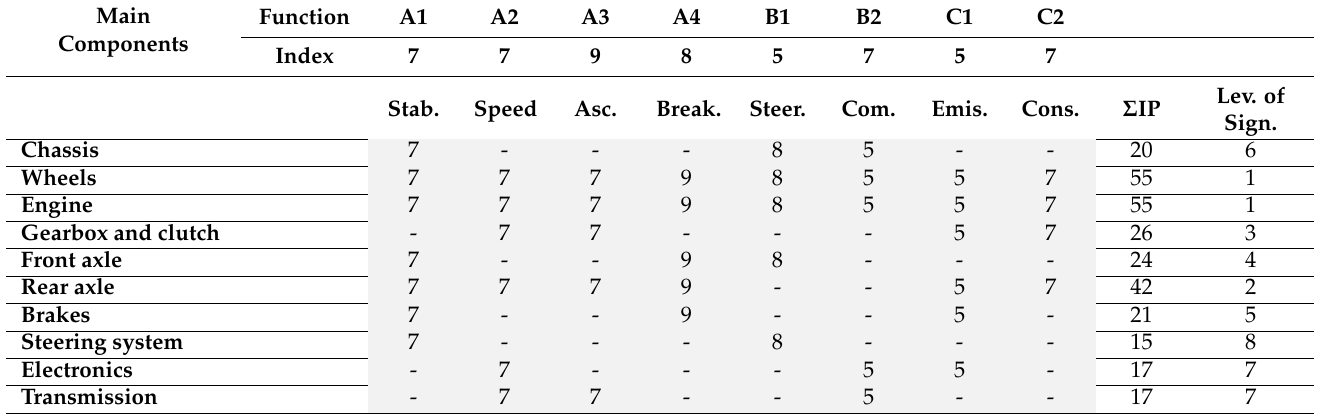
Table 3. Matrix of